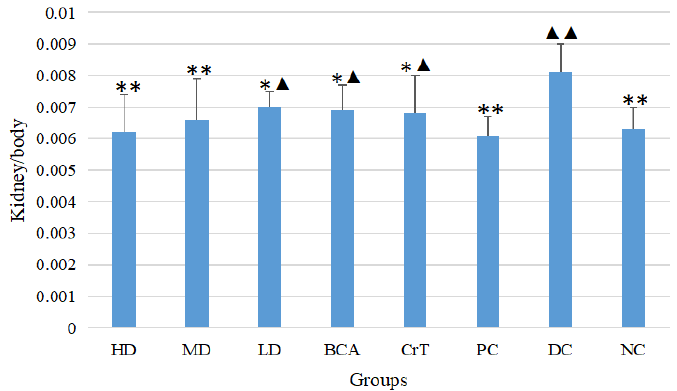
Figure 8. The kidney/body ratio after 4 weeks. Values are means ± SD ( n = 7). The differences between these groups and the DC group were statistically significant (denoted by “*” for p < 0.05, “**” for p < 0.01); the differences between these groups and the PC group were statistically significant (cid:78)(cid:78) (denoted by “ (cid:78) ” for p < 0.05, “ ” for p < 0.01). After 4 weeks, the OGTT results for each group were obtained (Figure 9). The glucose tolerances of the HD group and PC group were better than that of the DC group after 1 h of glucose administration ( p < 0.05). The glucose tolerances of the HD, BCA, CrT and PC groups were better than that of the DC group after 2 h of glucose administration ( p < 0.05). This indicated that [CrBCA 3 ] could improve the glucose tolerance of db/db mice.